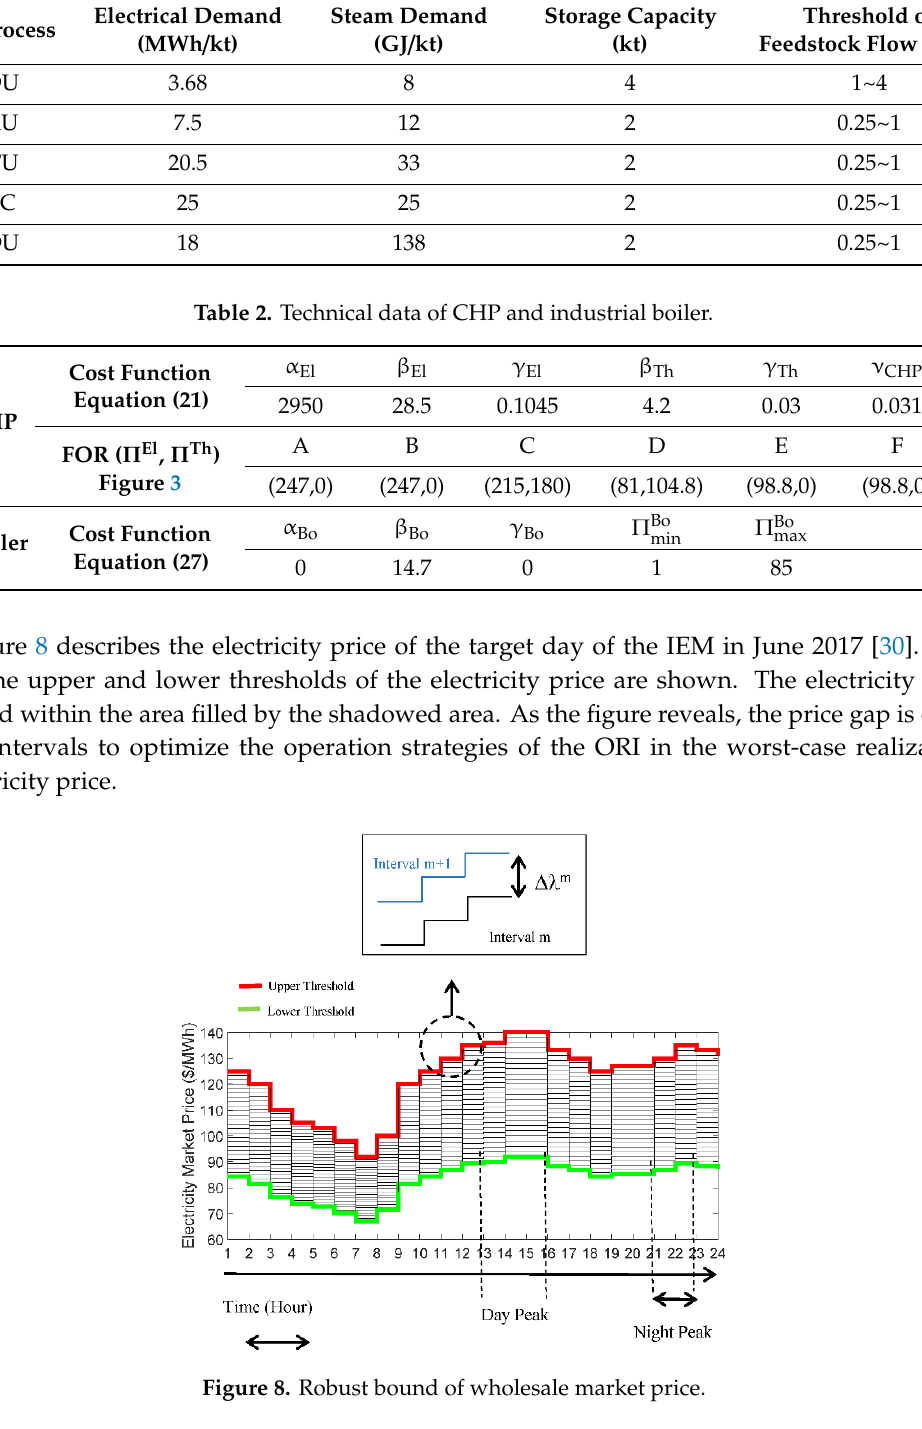
Figure 8. Robust bound of wholesale market price.